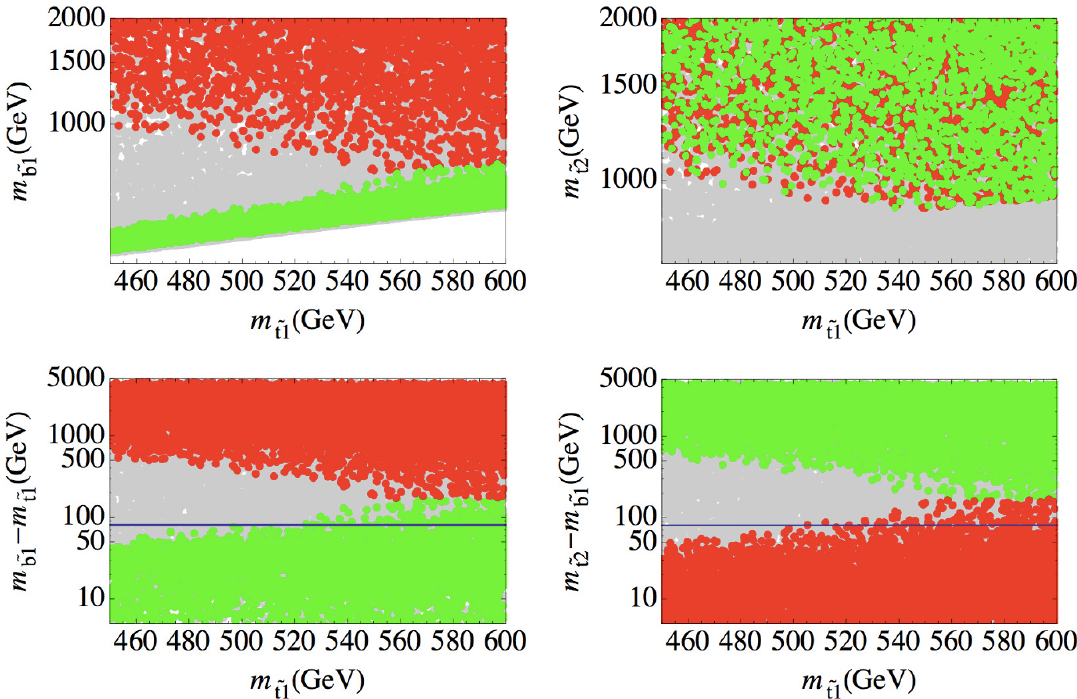
Figure 4 . Masses of sbottom (top left) and heavier stop (top right), and mass splittings between ~ b ~ b ~ t ~ t ~ t 1 and 1 (bottom left) and between 2 and 1 (bottom right) for light 1 masses. All points are compatible with (cid:21) hgg and (cid:1) (cid:26) constraints. Green (red) points are compatible with 120 (cid:20) m h (cid:20) 130 GeV for mostly left-handed (right-handed) ~ t 1 ; grey points have m h outside this window. The horizontal line in the bottom row corresponds to mass splitting equal to the W boson mass, which has important implications for collider